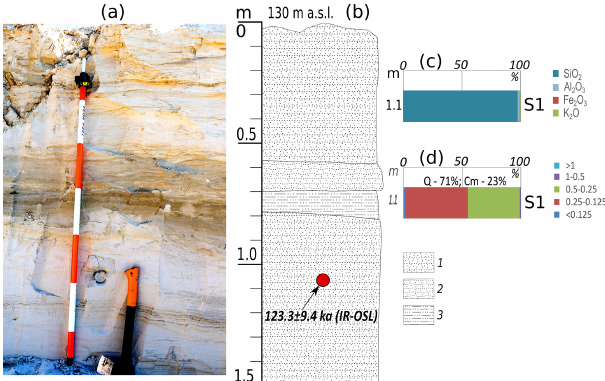
Figure 7. Summary results of research for section NS-22: (a) pho- tographs (by Sizov in 2018); (b) geological structure and the dating results (see Table 3); (c) bulk chemical data; (d) grain size distribu- tion (fractions,mm). Symbols: (1) horizontally layered grey sand; (2) oblique layered sand; (3) horizontally layered sandy loam; Q : coefficient of roundness of the sand quartz grain; Cm: degree of dullness; S: sample